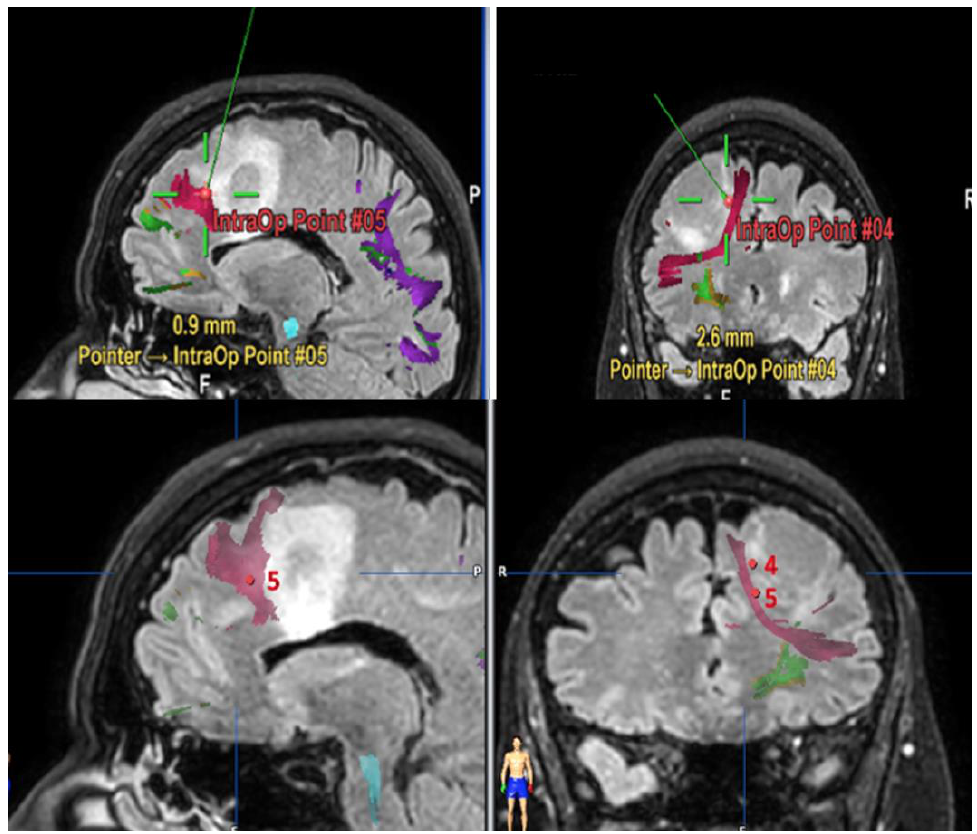
Figure 2. Intraoperative screenshots of FLAIR MRI sequences with navigated tractography of left frontal low-grade glioma. Point 4 corresponds to the stimulation of the medial part and the point 5 to the middle part of FAT.